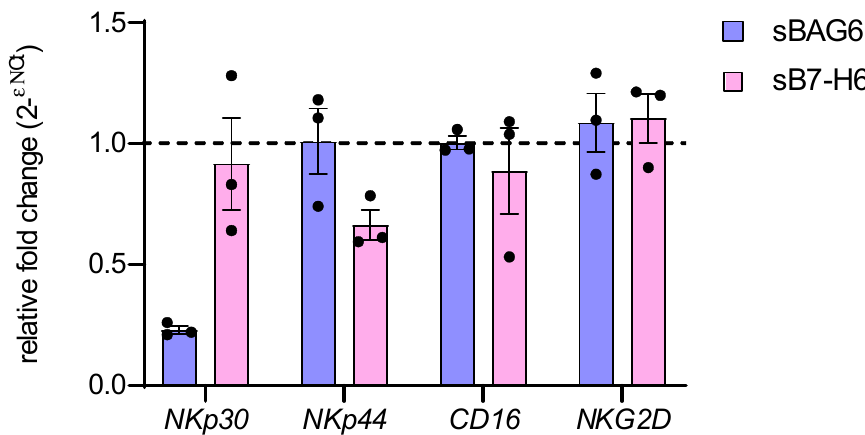
Figure 5. NKp30 mRNA expression decreases upon treatment with soluble BAG6. NK cells were treated for 24 h with soluble BAG6 (sBAG6) or B7H6 (sB7H6). Fold change of mRNA expression of NKp30 , NKp44 , CD16 , and NKG2D was analyzed by RT-qPCR and normalized to GAPDH and L27 mRNA (2 ∆∆ Ct ). Three biological replicates (donors) were analyzed.